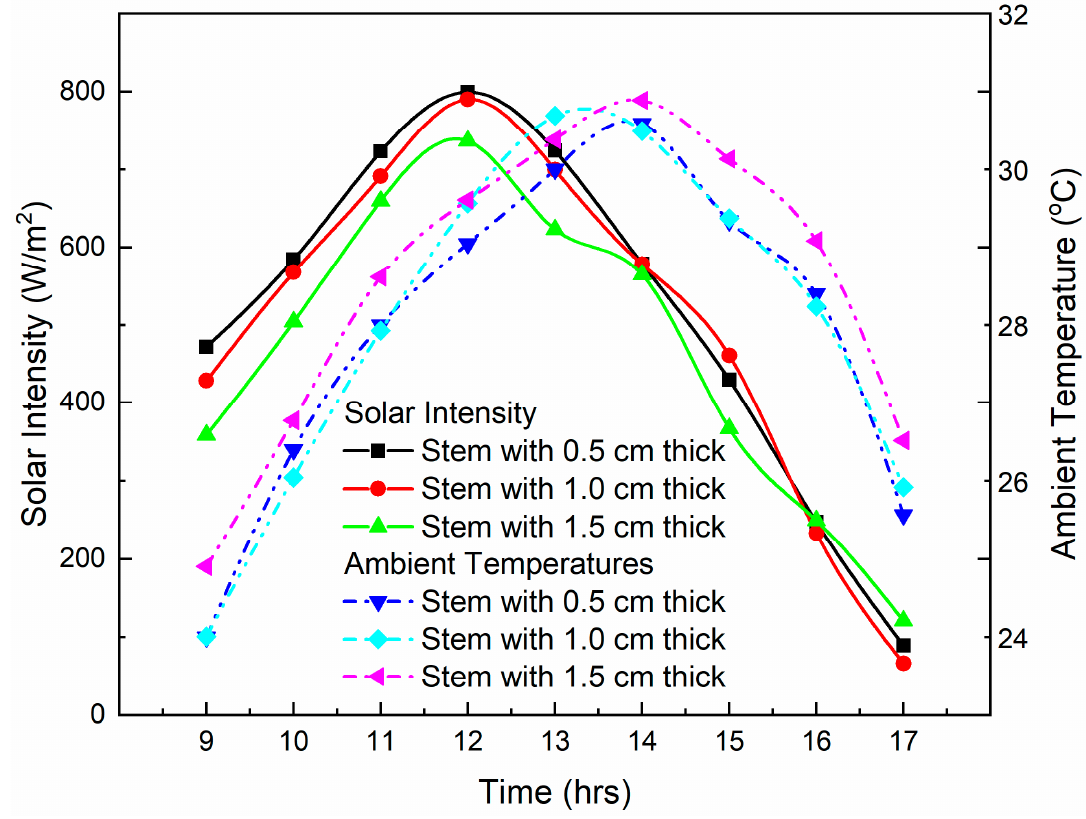
Figure 3. Variation in solar irradiance and ambient temperature.